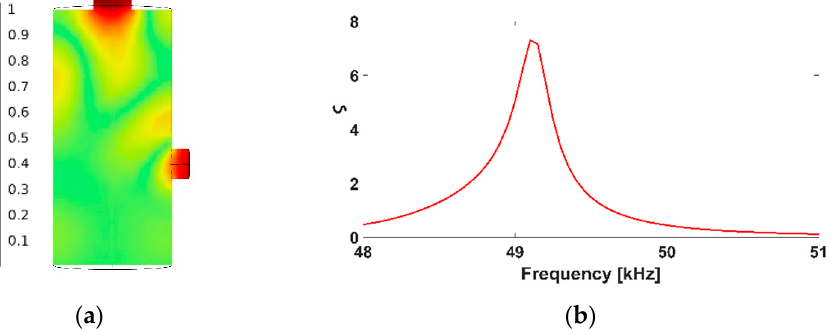
Figure 9. (a): Absolute pressure distribution inside the optimized resonator at 49.2 kHz. (b): Relative PA signal of the optimized resonator around 49.2 kHz.